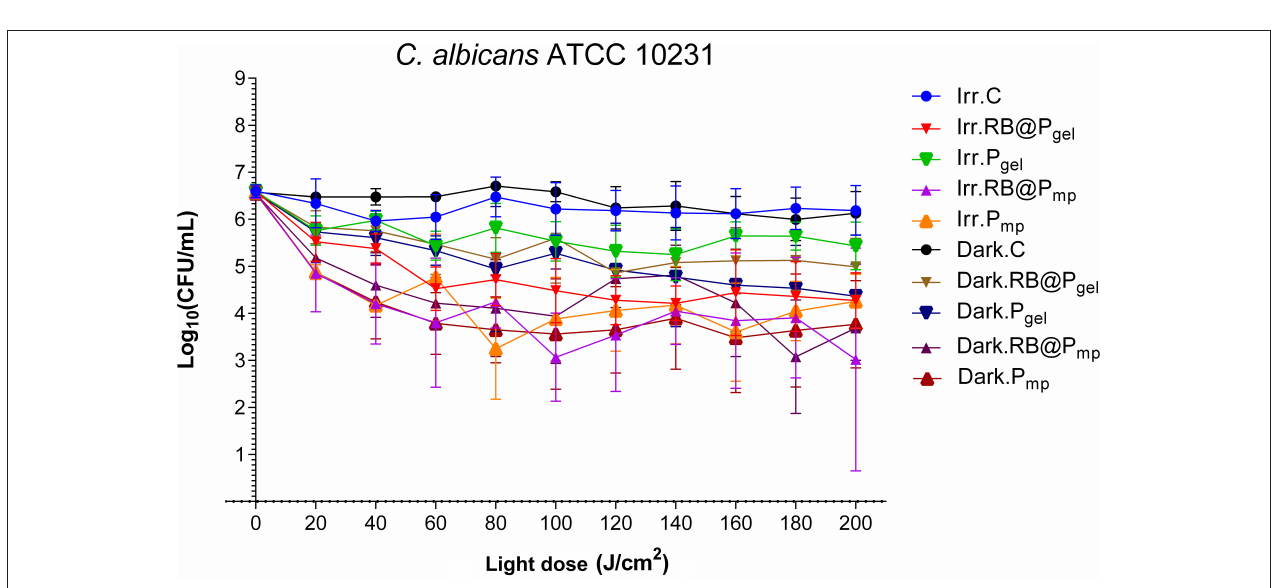
FIGURE 5 | Survival curves corresponding to the photodynamic inactivation of Candida albicans . Every point is the average of three independent experiments. Error bars correspond to the standard deviations. Legend titles: Irr , irradiated samples; Dark , controls in the darkness; C , control, only microbial suspension; RB@P gel , Amberlite ® IRA-400 (P gel ) loaded with Rose Bengal (RB); P gel , P gel resin without RB; RB@P mp , Amberlite ® IRA-900 (P mp ) loaded with RB; P mp , P mp resin without RB.